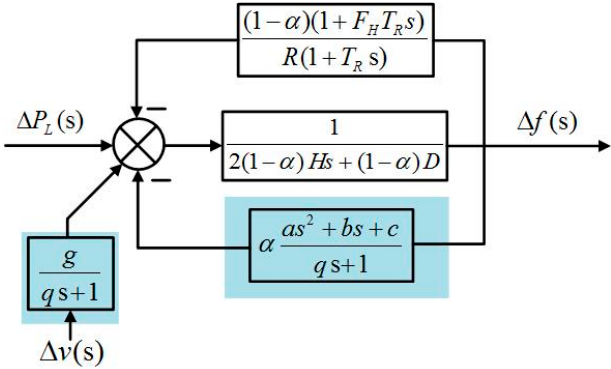
Figure 2. Extended system frequency response (SFR) model for the high-wind integrated power system.